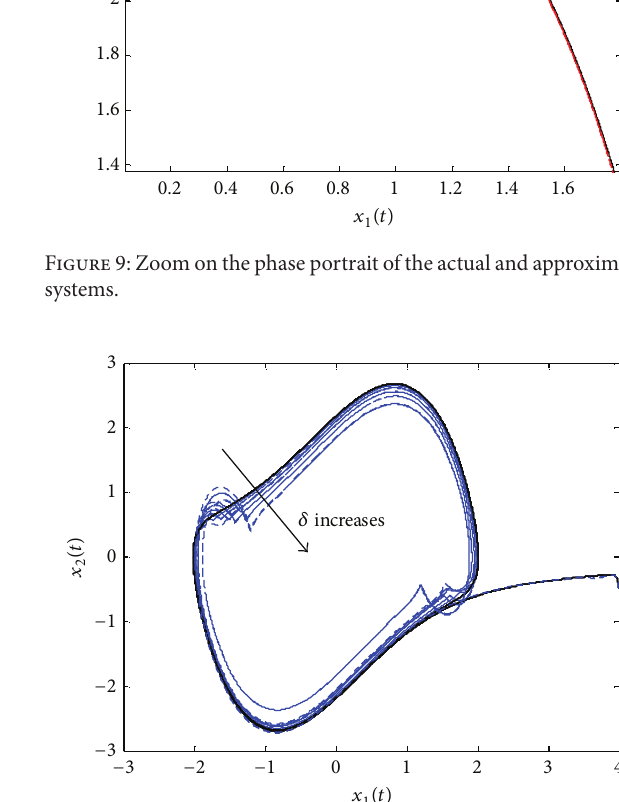
Figure 10: Effect of the variation of the sampling threshold 𝛿 in the approximate